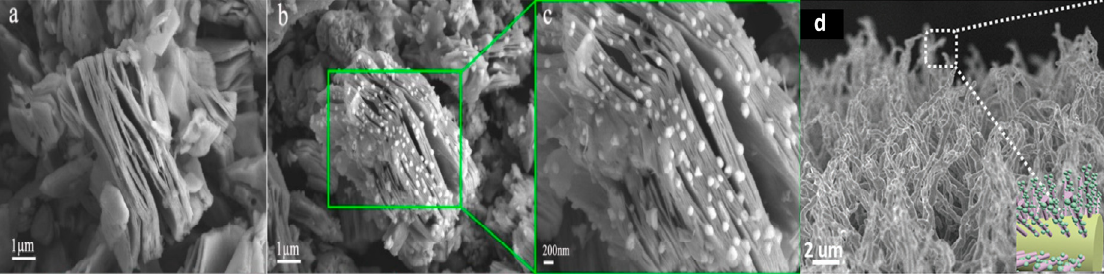
Figure 3. ( a , b ) Morphology of MXene/50% CuO nanocomposite, ( c ) MXene/50% CuO nanocomposite and ( d ) Ti 3 C 2 /Cu 2 O (magnification: 200 nm). Reprinted with permission from [48,50].